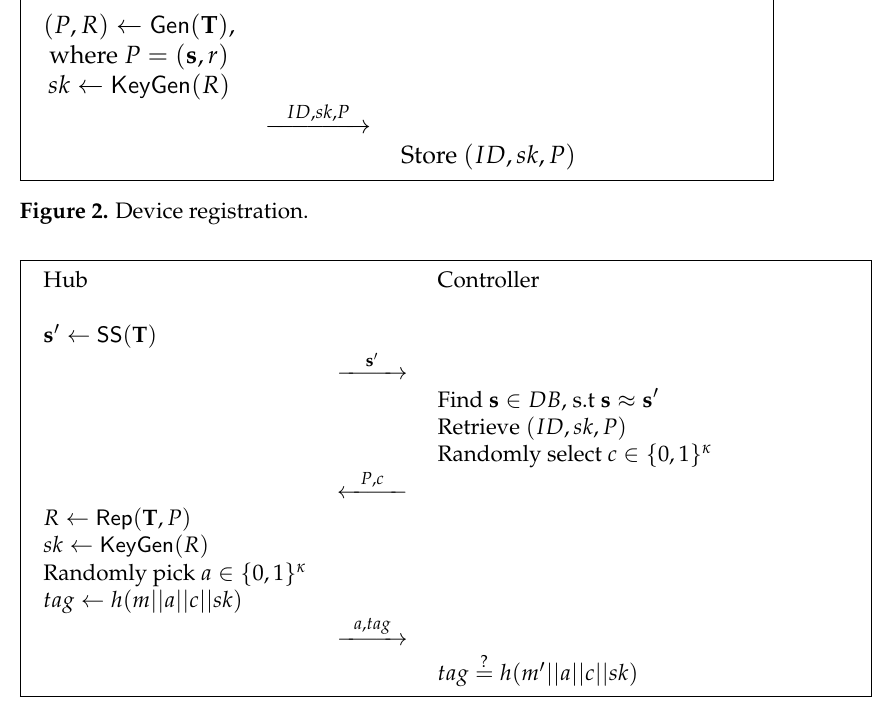
Figure 3. Lightweight Time-Based Identification Protocol